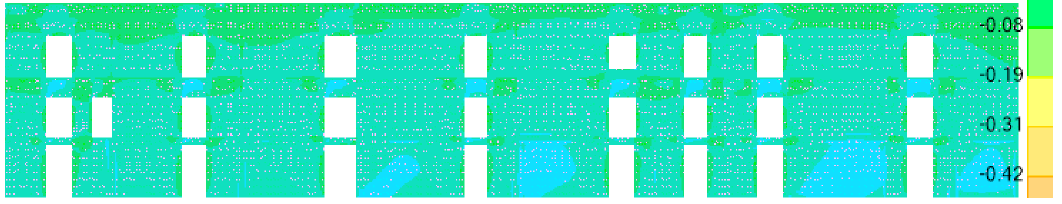
Figure 16. Shearing force per meter at section cut-3 (Figure 10) under load combination dead + live + response spectrum ‐ x.